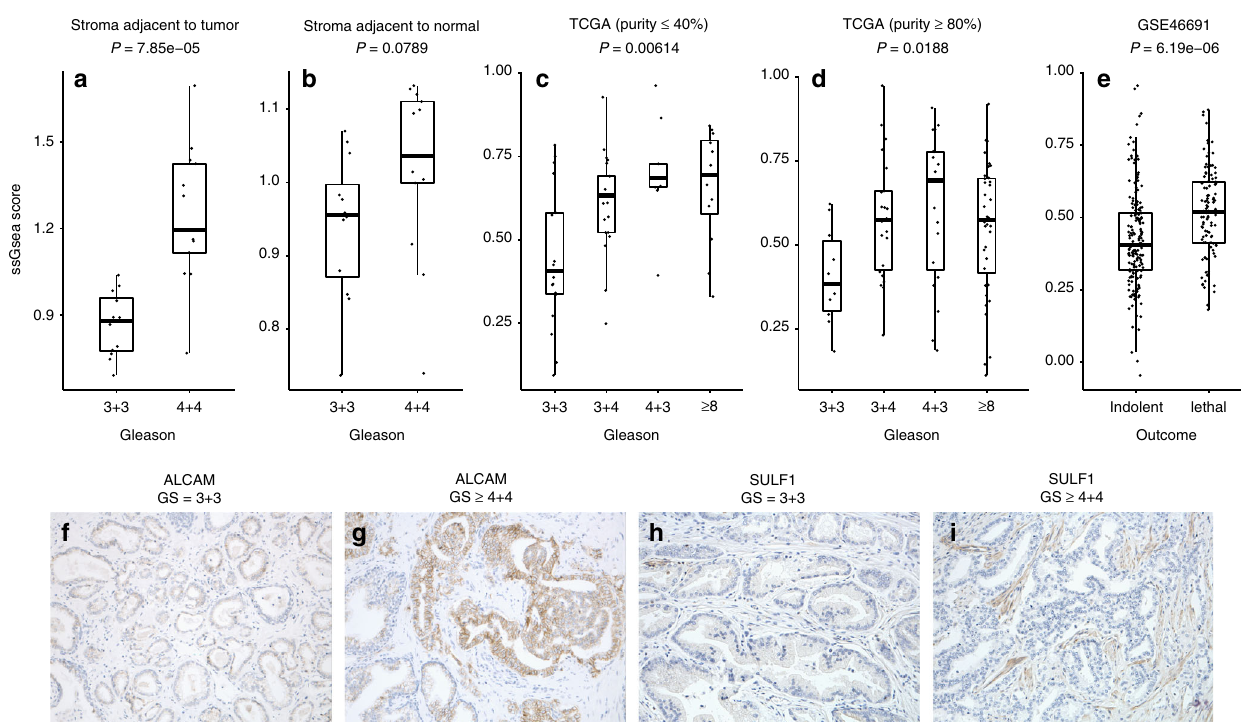
Fig. 4 Genes differentially expressed in stroma surrounding high-Gleason grade and low-Gleason grade prostate tumors. a ssGSEA score of the stromal signature in tumor adjacent stroma; b ssGSEA score of the stromal signature in benign-adjacent stroma; c ssGSEA score of the stromal signature in low cellularity TCGA samples; d ssGSEA score of the stromal signature in high cellularity TCGA samples; e ssGSEA score of the stromal signature between indolent and lethal cases from GSE46691 cohort; f Immunohistochemical staining of epithelial ALCAM in Gleason 3 + 3 case; g Immunohistochemical staining of epithelial gene ALCAM in Gleason 4 + 4 case; h Immunohistochemical staining of stromal SULF1 in Gleason 3 + 3 case; i Immunohistochemical staining of stromal SULF1 in Gleason 3 + 3 case. P -values in ( a – e ) are from corresponding t